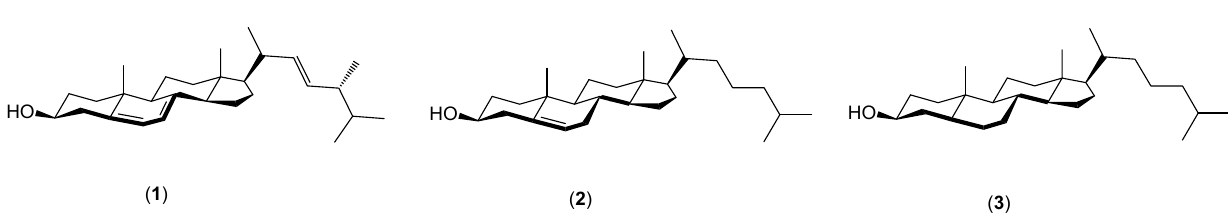
Figure 2. The structure of ergosterol ( 1 ), cholesterol ( 2 ) and cholestanol ( 3